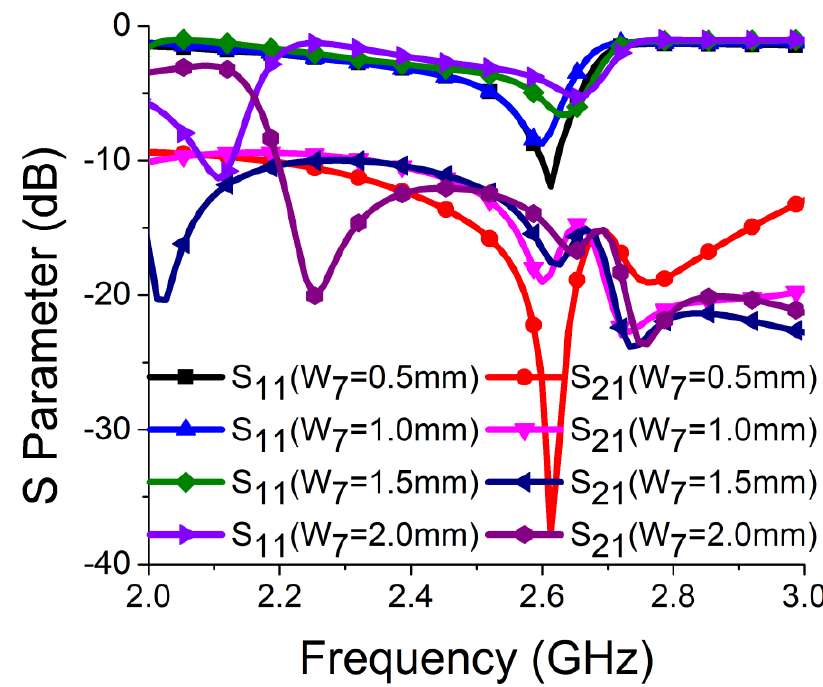
Figure 7. Effect of W 7 on resonance and isolation.